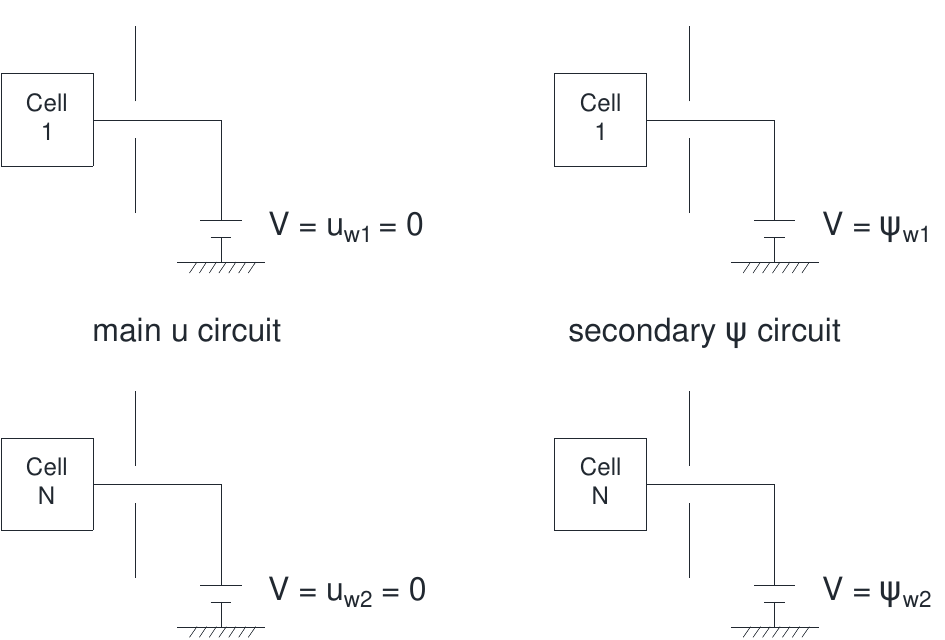
Figure 3. Elements associated with the boundary conditions in rectangular domains.